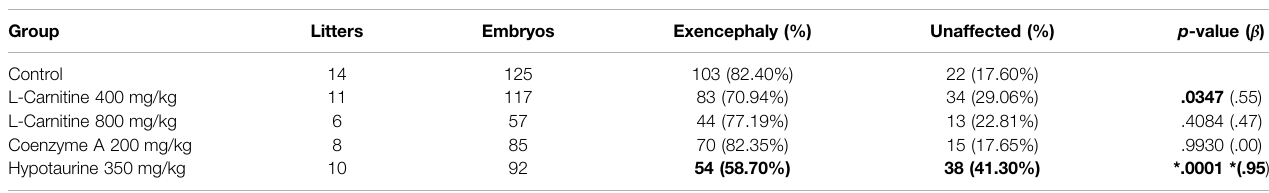
p-values less than .05 and β values greater than .80 are highlighted with bold font.